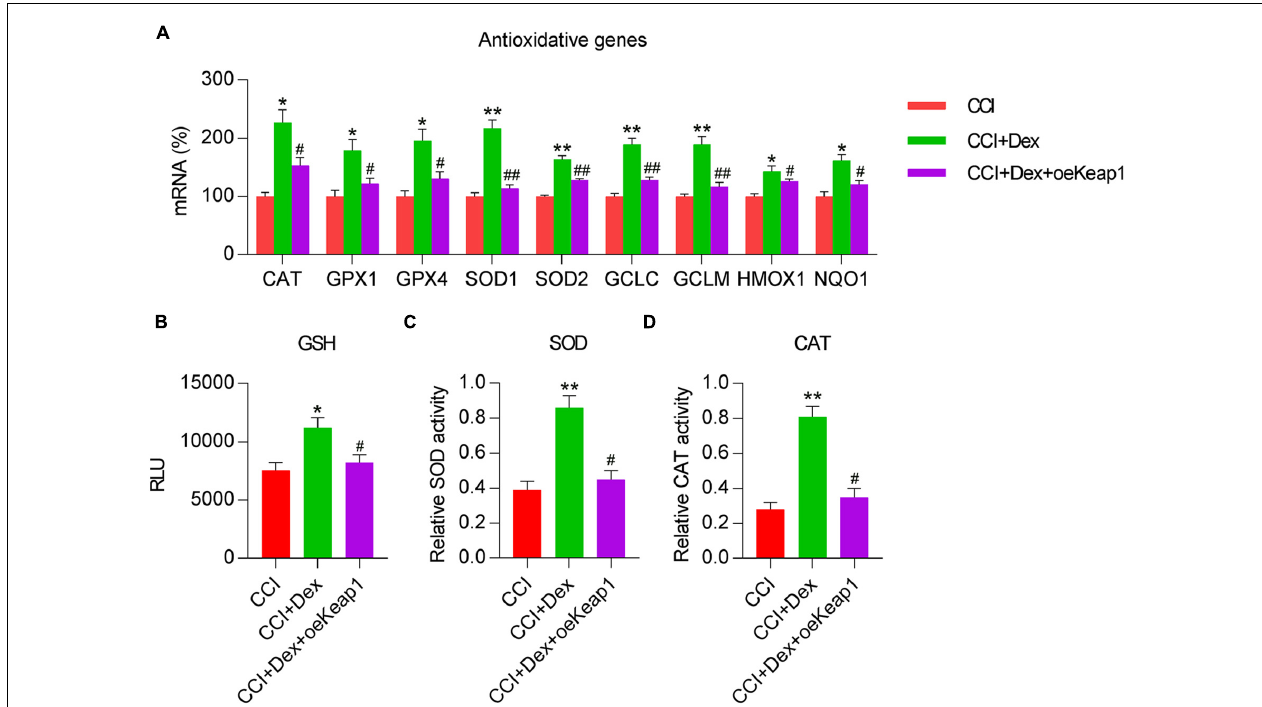
FIGURE 6 | Effect of Keap1 overexpression on Dex-alleviated antioxidant capacity in spinal cord tissues of rats. Rats were intrathecally injected with lentiviral-NC or lentiviral-Keap1 for 1 week and then subjected to Dex treatment and CCI surgery. (A) Levels of antioxidant genes in the spinal cord were determined using quantitative polymerase chain reaction. (B) Analysis of glutathione levels in spinal cord tissue. (C) Superoxide dismutase activity in spinal cord tissues was examined using a SOD assay kit. (D) Analysis of catalase activity. * P < 0.05, ** P < 0.01 vs. CCI group; # P < 0.05, ## P < 0.01 vs. CCI + Dex group.